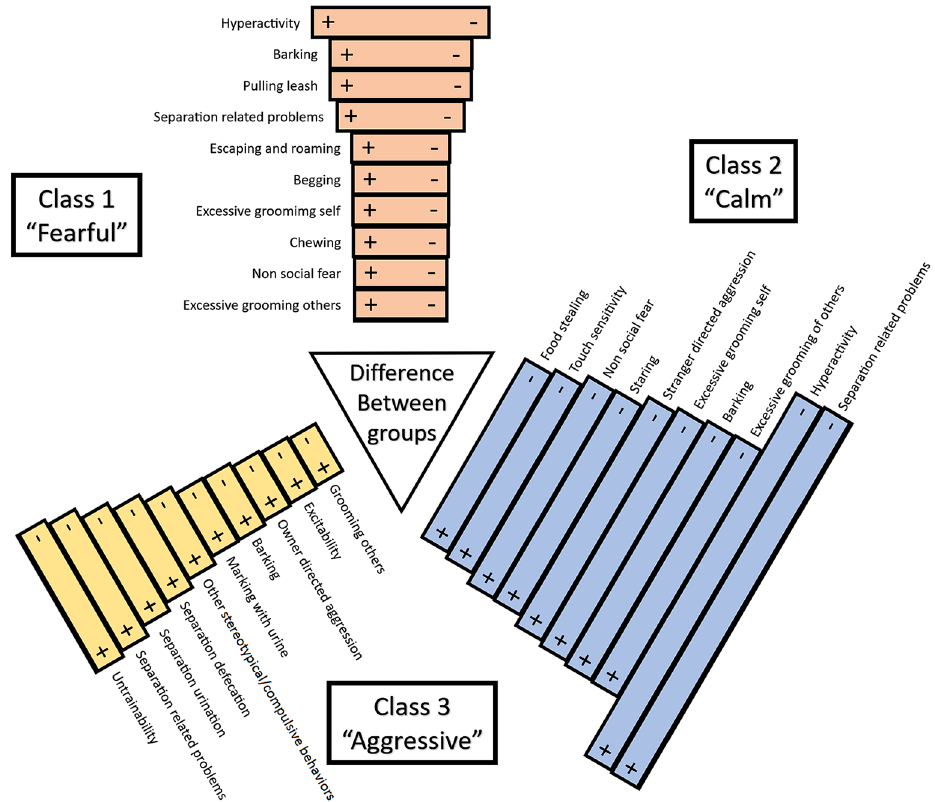
Figure 3. Personality profiles difference diagram for the 3-class model. These personality profiles are defined by the 10 top ranked traits based on their probability estimate pairwise differentials. The size of the bars is proportional to the square difference value for the trait. Plus (+) and minus (−) signs indicate the direction of the severity of the trait according to each pairwise